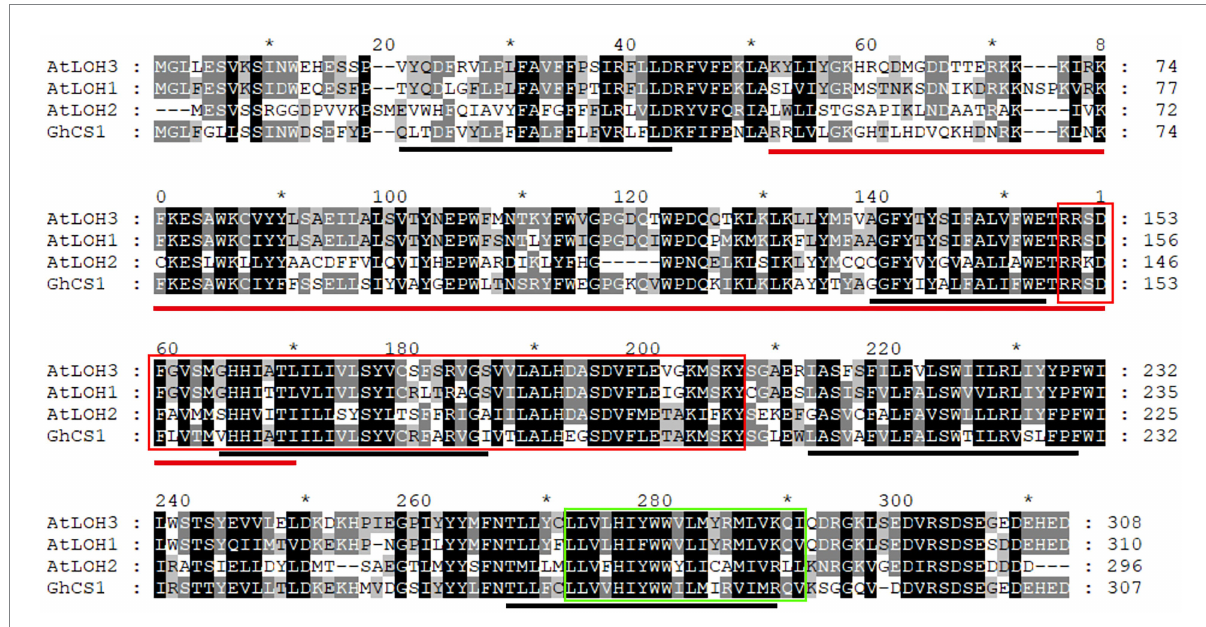
FIGURE 2 Alignment of GhCS1 with three Arabidopsis ceramide synthase. AtLOH1 ~ 3: Arabidopsis ceramide synthase 1 ~ 3. The red line shows the conserved domain of TLC; the black line shows the five transmembrane regions; the red box represents the conserved domain of LAG1 (LONGEVITY ASSURANCE GENE 1); the green box represents the conserved domain of glycerol-3-phosphate